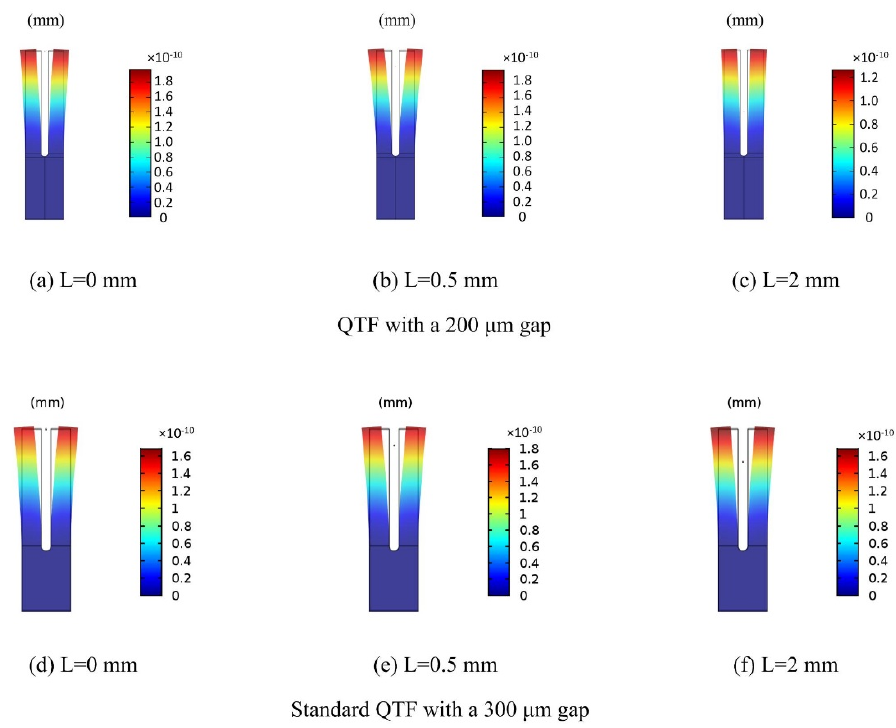
Figure 3. Calculated deformation with various acoustic wave excitation positions (L) for two different QTFs: ( a – c ) for the QTF with a 200 μ m gap; ( d – f ) for the standard QTF with a 300 μ m gap.